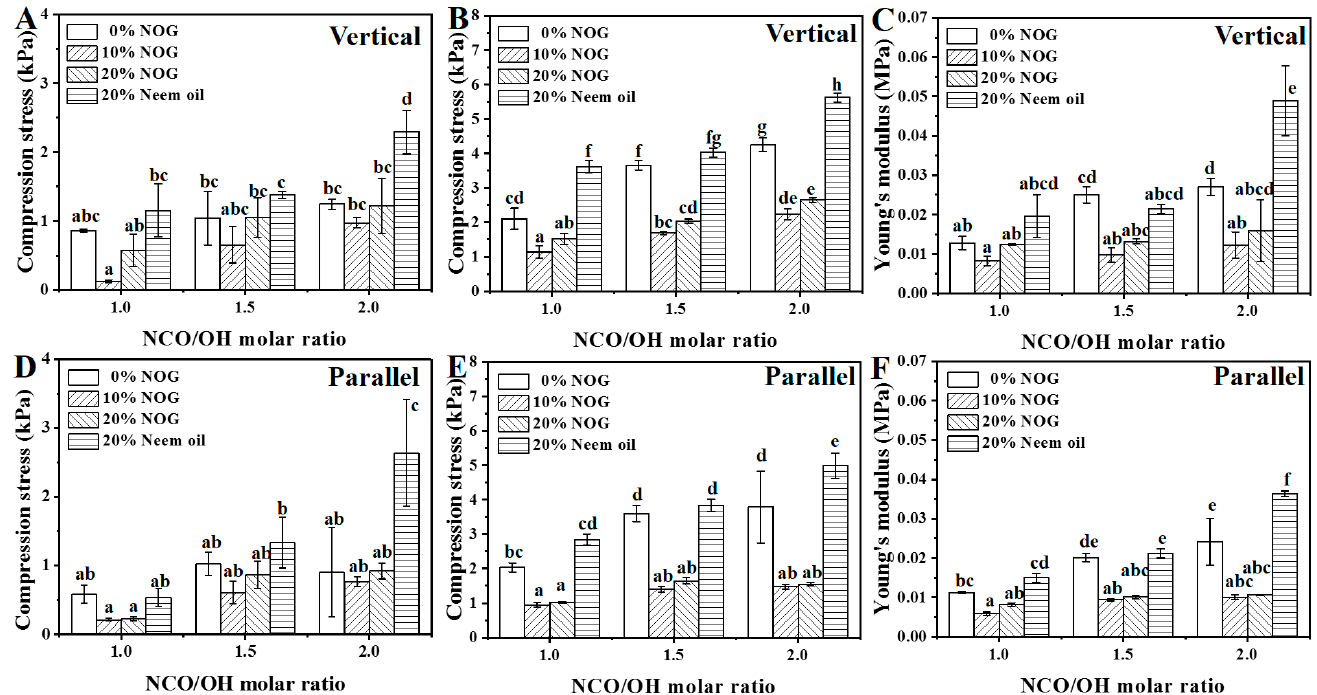
Figure 6. Compressive strength at 10% ( A , D ) and 25% ( B , E ) strain and young’s modulus ( C , F ) in the vertical and parallel directions. The NCO/OH molar ratios of O1-2, O2-2 and O3-2 set as 1.3, 1.9 and 2.5, respectively. The data analyzed using one-way ANOVA with Scheffe’s test, the different lowercase letters indicate statistical differences in the bar graph.